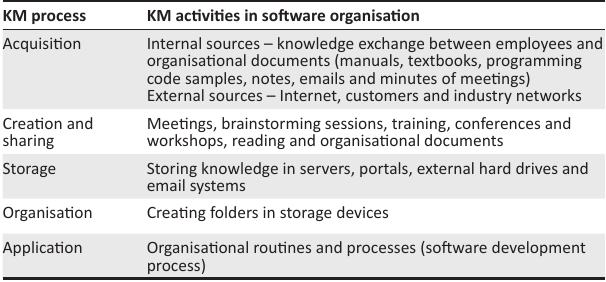
TABLE 1: Summary of knowledge management